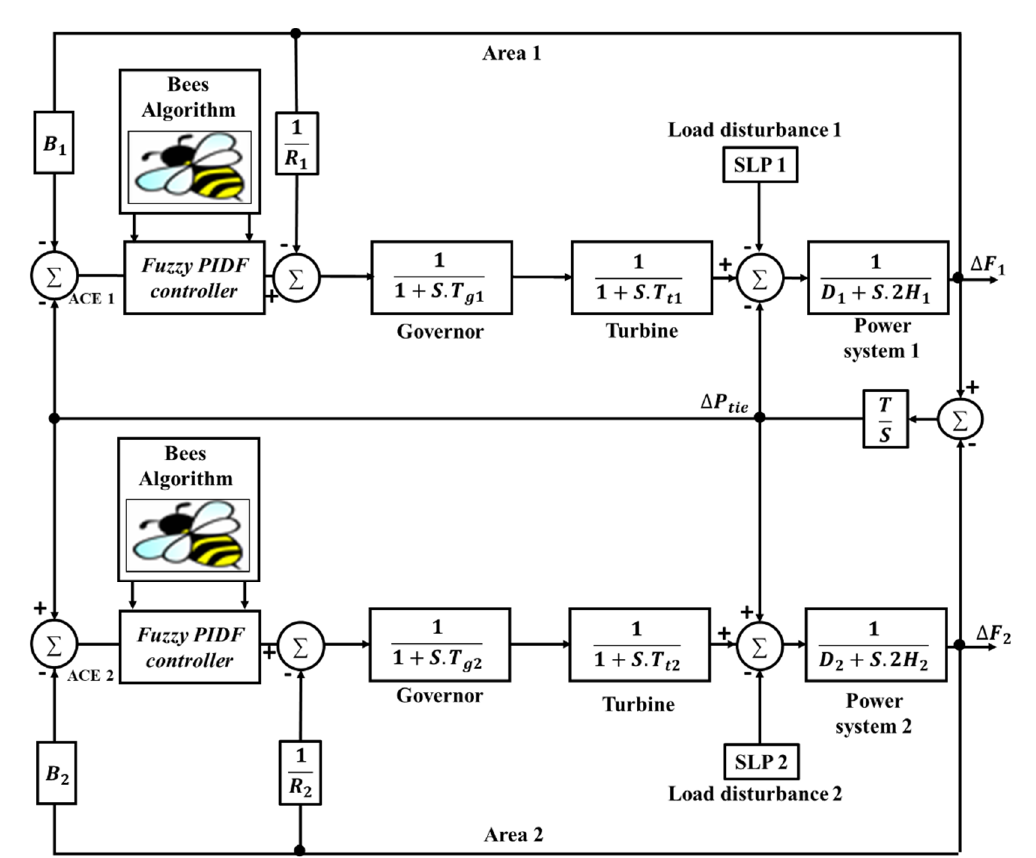
Figure 17. Transfer function model of the investigated dual-area power system. The term defined as Area Control Error (ACE) in each area is the input of the controller located in that area. In this model, the ACEs are represented in Equations (5) and (6).